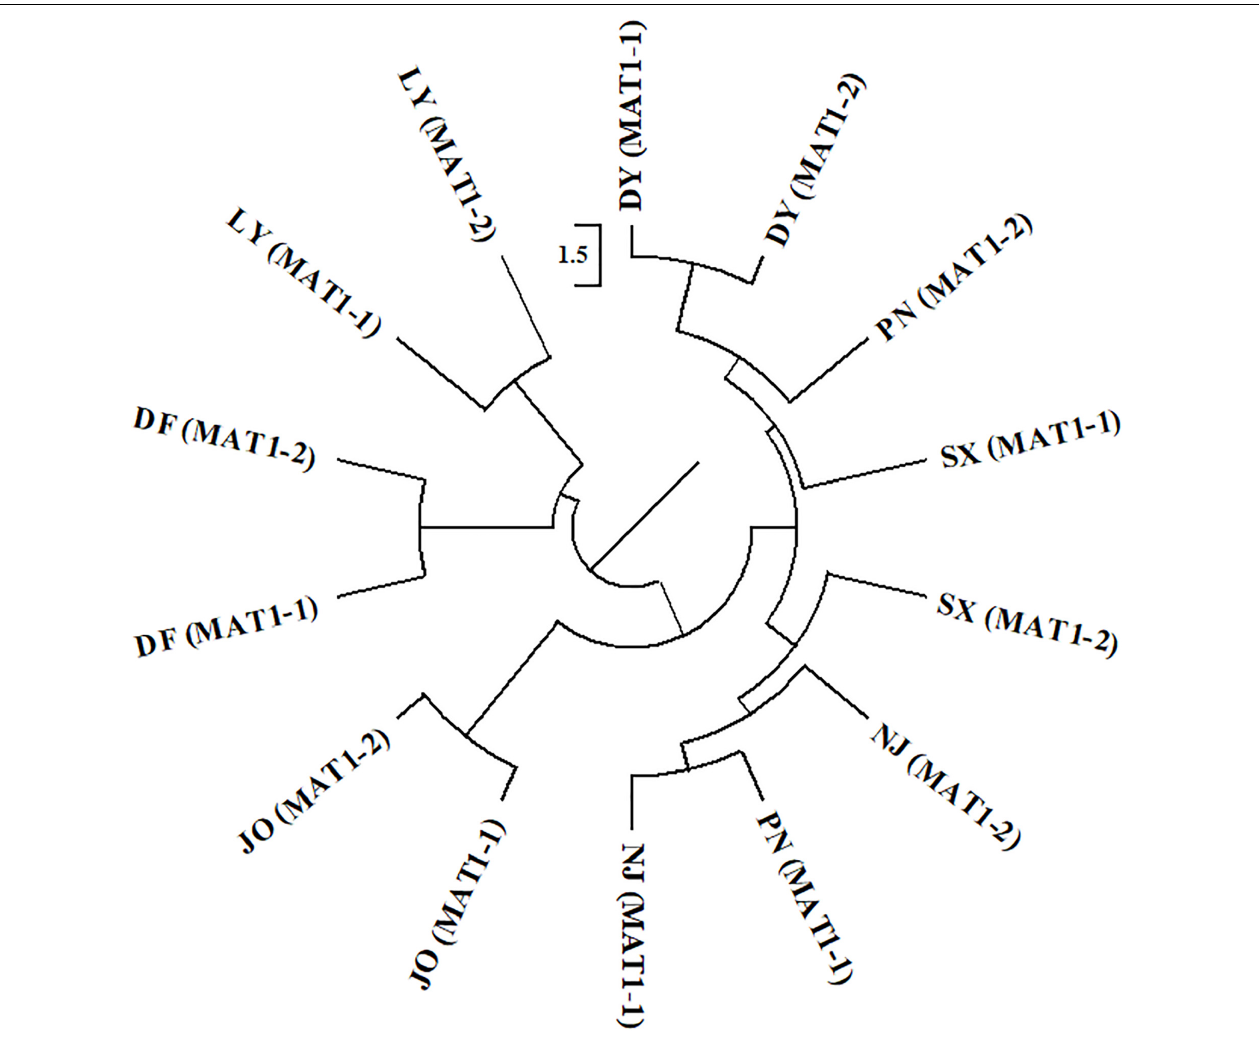
FIGURE 2 | Phylogenetic dendrogram of the two mating types of Setosphaeria turcica from seven regions in Fujian Province based of inter-simple sequence repeat markers. DY, JO, PN, SX, LY, DF, and NJ represent S. turcica isolates collected from the Dongyou (23 isolates), Jian’ou (27), Pingnan (15), Songxi (18), Longyan (11), Dongfeng (14), and Nanjing (9) regions of Fujian Province, respectively. Isolates of the two mating types obtained from DY, JO, LY, and DF were, respectively clustered, indicating a lack of genetic differentiation between the MAT1-1 and MAT1-2 populations from these regions. The MAT1-1 and MAT1-2 isolates from PN, SX, and NJ were randomly clustered into different groups, implying that there is a genetic differentiation between the two mating type populations from these three